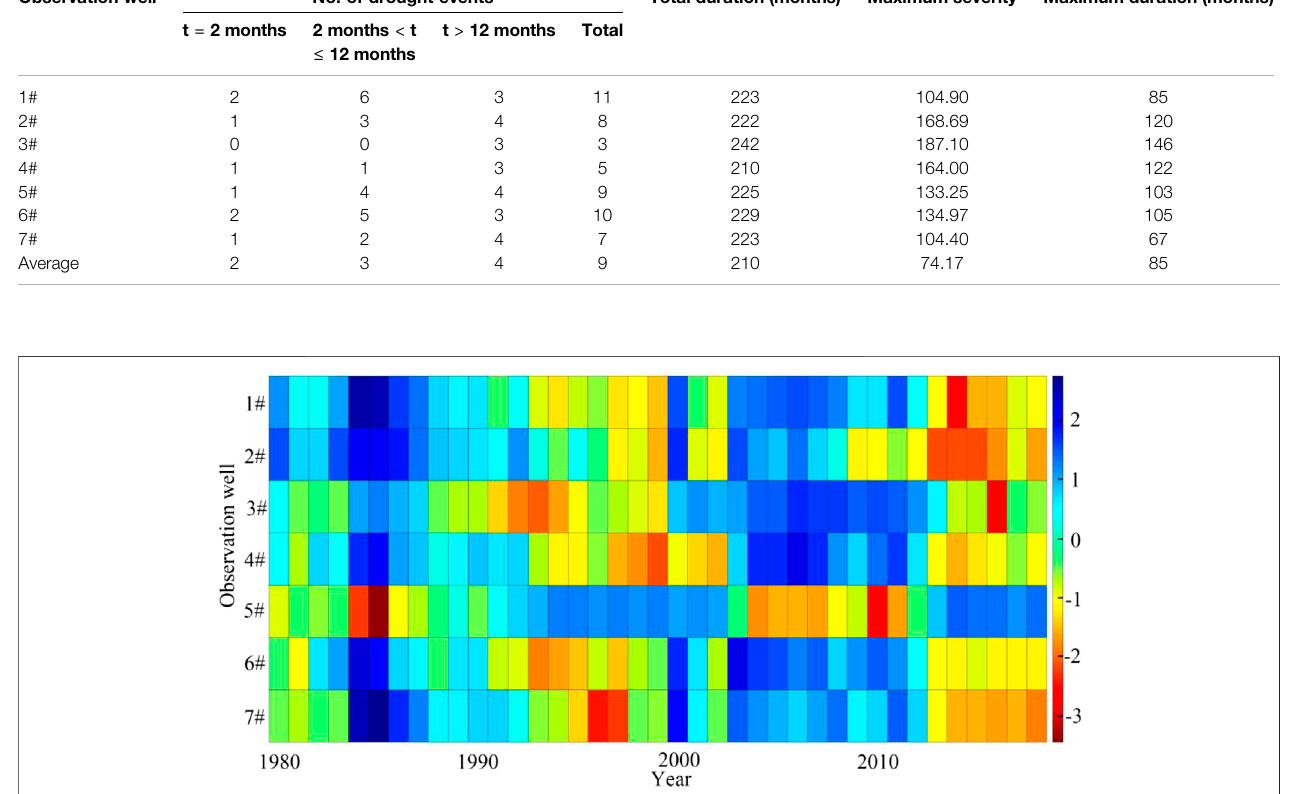
TABLE 2 | Drought characteristics based on SGI values for seven observation wells. Observation well